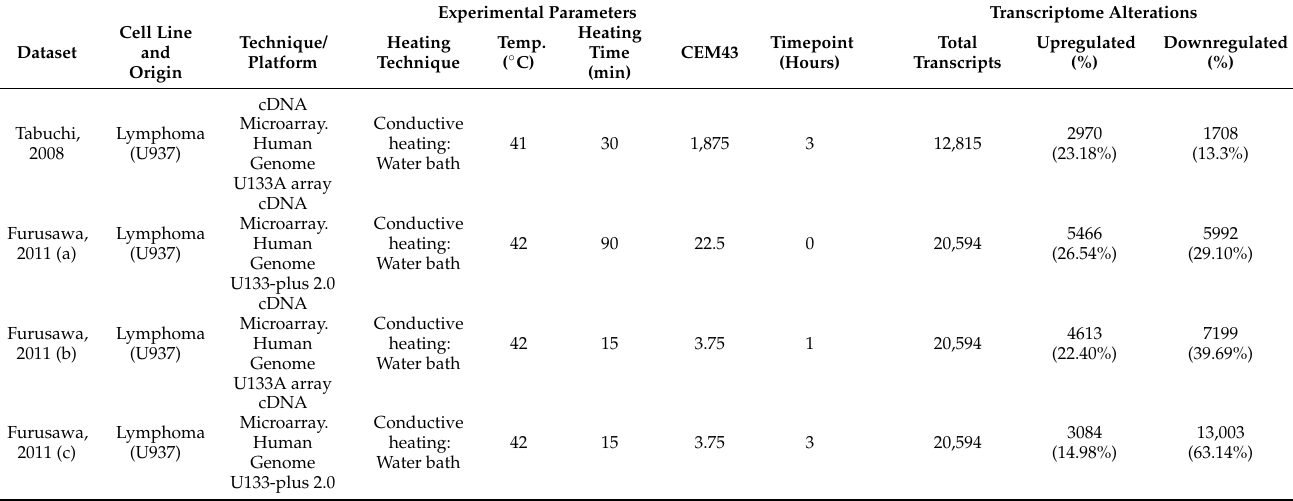
Table 2. Comparison of studies and datasets included in the